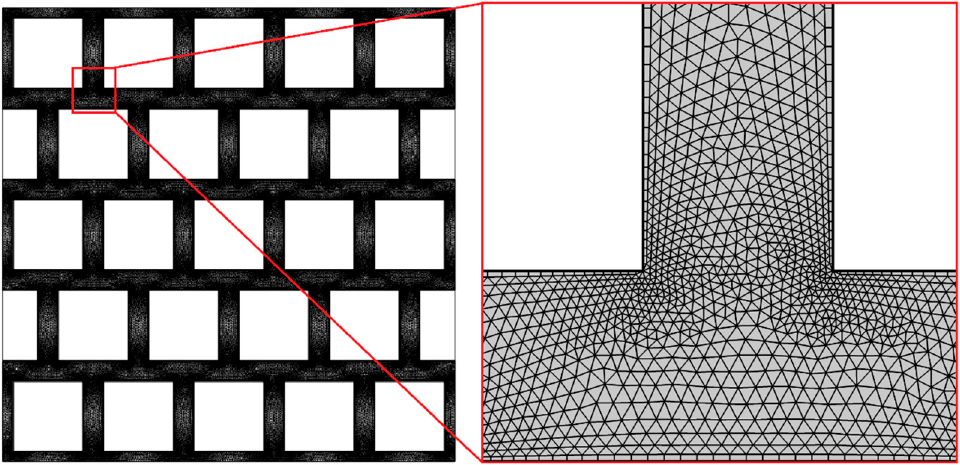
Figure 3. Finite element grid.